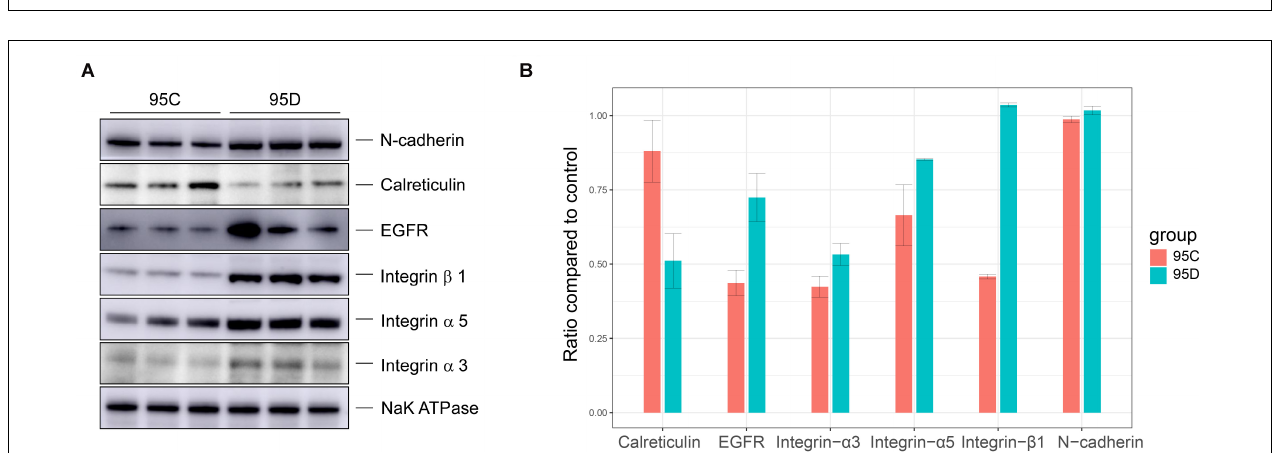
FIGURE 3 | Kaplan-Meier curves of overall survival for CHE2, EGFR, ITGA3, ITGA5, ITGB1, and CALR.